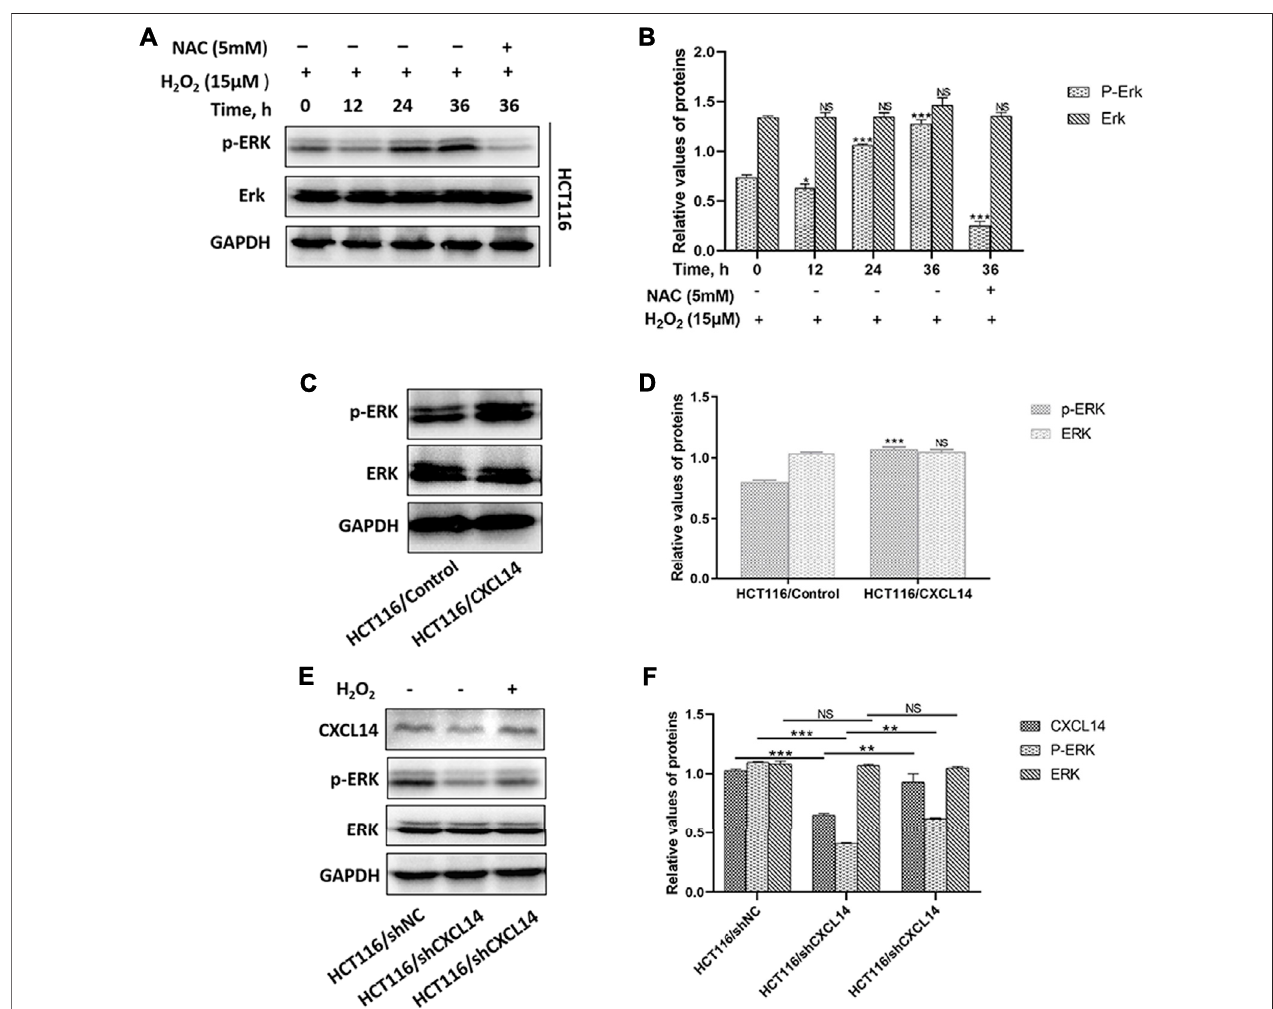
FIGURE 6 | Effects of CXCL14 on the ROS-induced phosphorylation of ERK. (A) H 2 O 2 increased the expression levels of CXCL14 and p-ERK in HCT116 cells treated without or with 15 μ M H 2 O 2 or pretreated with 5 mM NAC in a time-dependent manner. (B) Quantitative results of the expression levels of p-ERK. (C) CXCL14 could up-regulated the phosphorylation level of ERK in HCT116/CXCL14 cells. (D) Quantitative results of the p-ERK and total ERK expression levels in the HCT116/ CXCL14 cells and HCT/Control cells. (E) CXCL14-de fi ciencymarkedly inhibited the phosphorylation ofERK inHCT116/shCXCL14 cellswhen compared withthat in HCT116/shNC. (F) Quantitative results of the p-ERK and total ERK expression levels in HCT116/shCXCL14 and HCT116/shNC cells. All experiments were repeated three times or more. Error bars represent ± S.D. p < 0.05 was considered to be statistically signi fi cant. * p < 0.05; ** p < 0.01, *** p < 0.001.